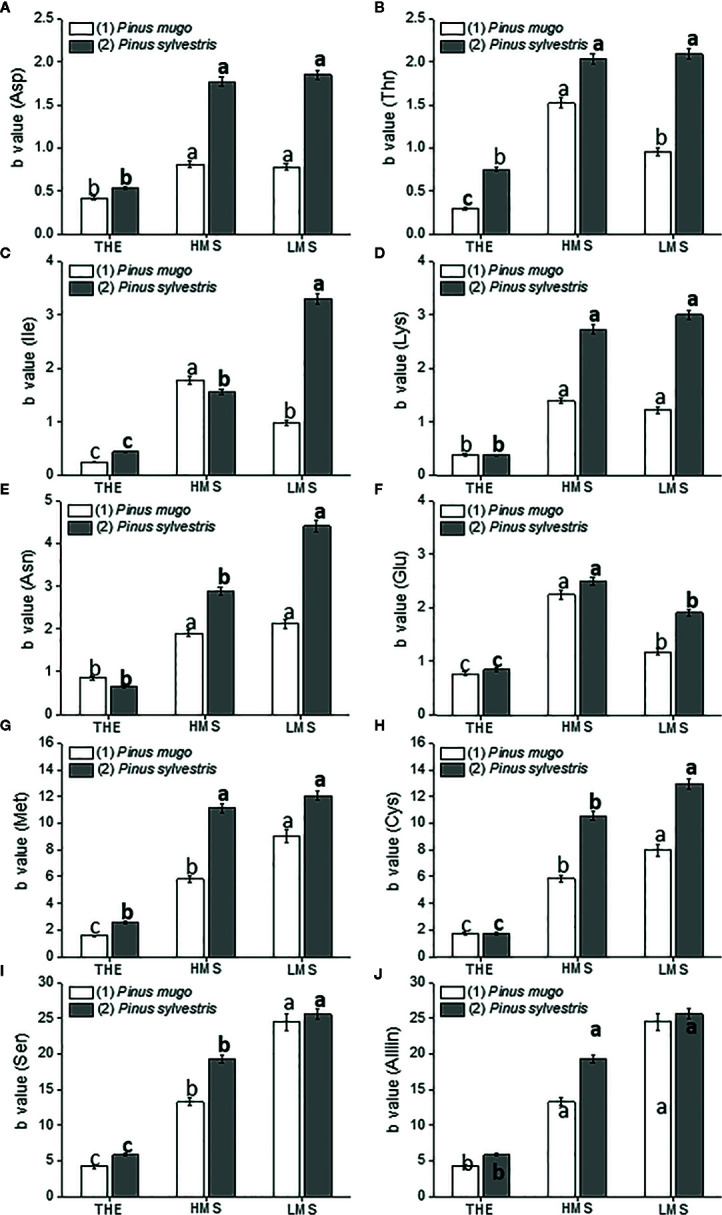
Amino acid content in roots of garlic plantlets grown in hydroponics and treated for 48 h with total humic extracts (THE) and size-fractionated HS (high molecular size, HMS and low molecular size, LMS) extracted from soil (1) (with Pinus mugo cover) and (2) (with Pinus sylvestris cover). The b values of the regression curve in the range 0 –1mg C L−1 are reported. Panels are: (A) Asp, asparagine; (B) Thr, threonine; (C) Ile, isoleucine; (D) Lys, lysine; (E) Asn, asparagine; (F) Glu, glutamate; (G) Met, methionine; (H) Cys, cysteine; (I) Ser, serine; (J) Aliin. Different letters represent significant differences at p < 0.05 (n = 5). Letters not in bold compare HS from soil (1), letters in bold compare HS from soil (2).